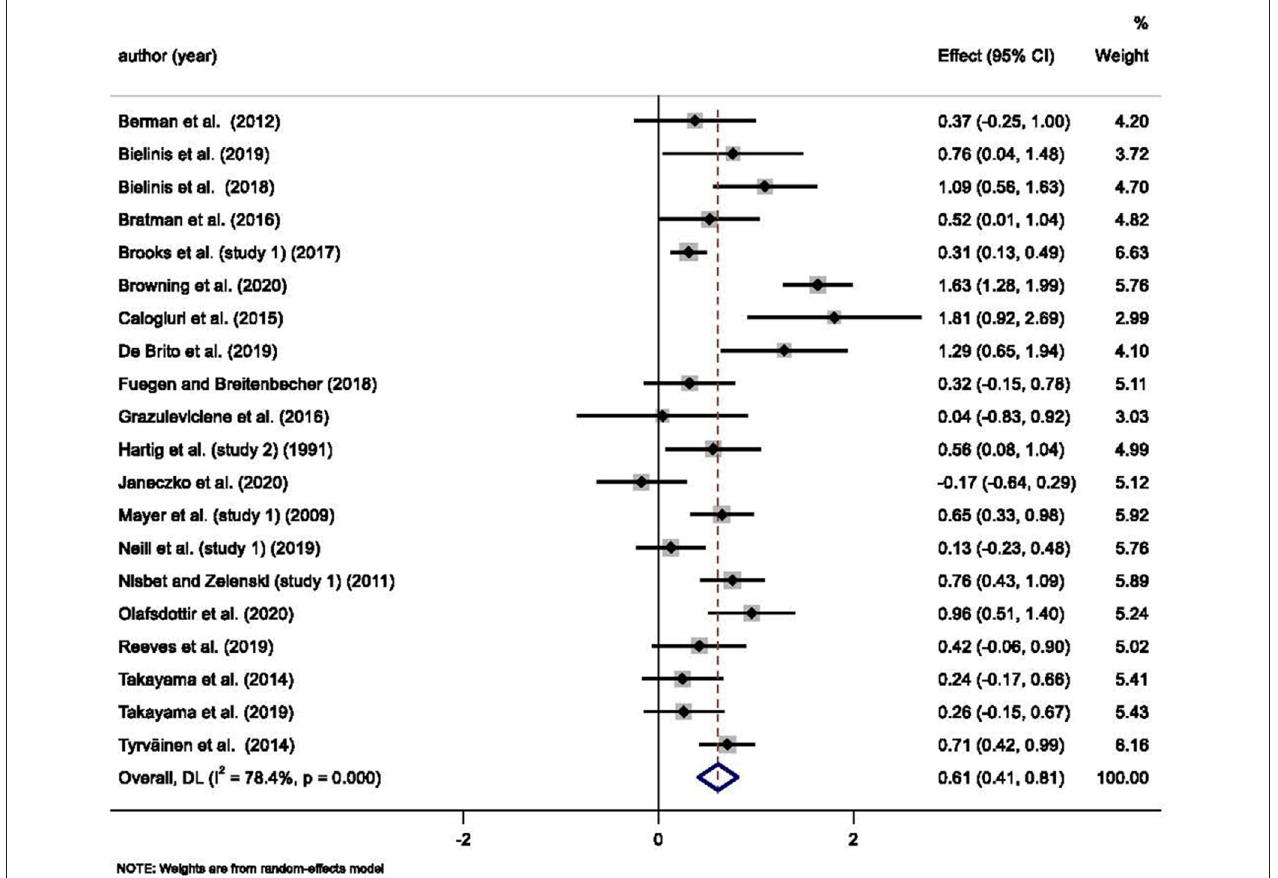
FIGURE 2 | Meta-analysis results for the association between natural and built environment exposure on positive